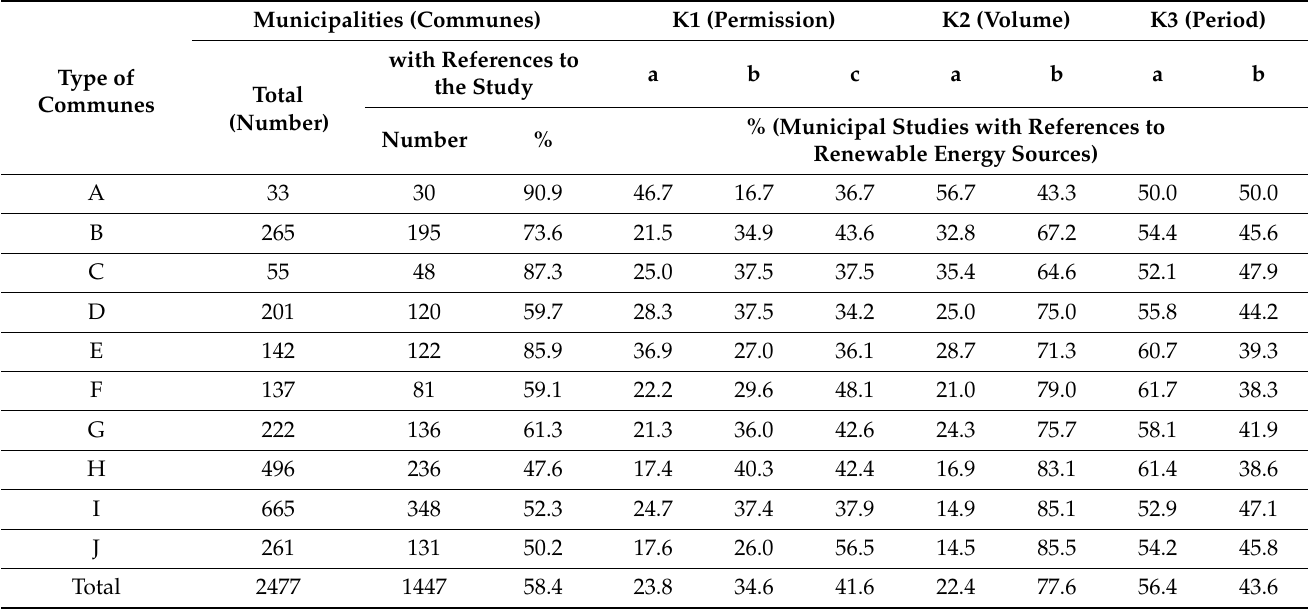
Table 1. Characteristics of references to RES in studies of spatial development conditions and directions of municipalities.